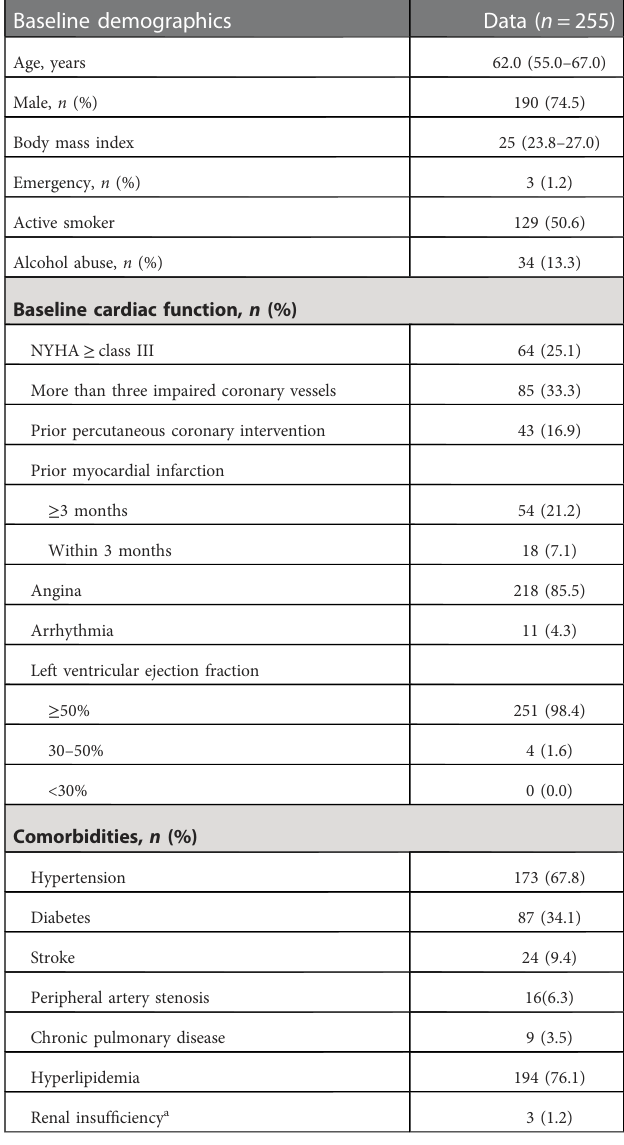
TABLE 1 Baseline characteristics.